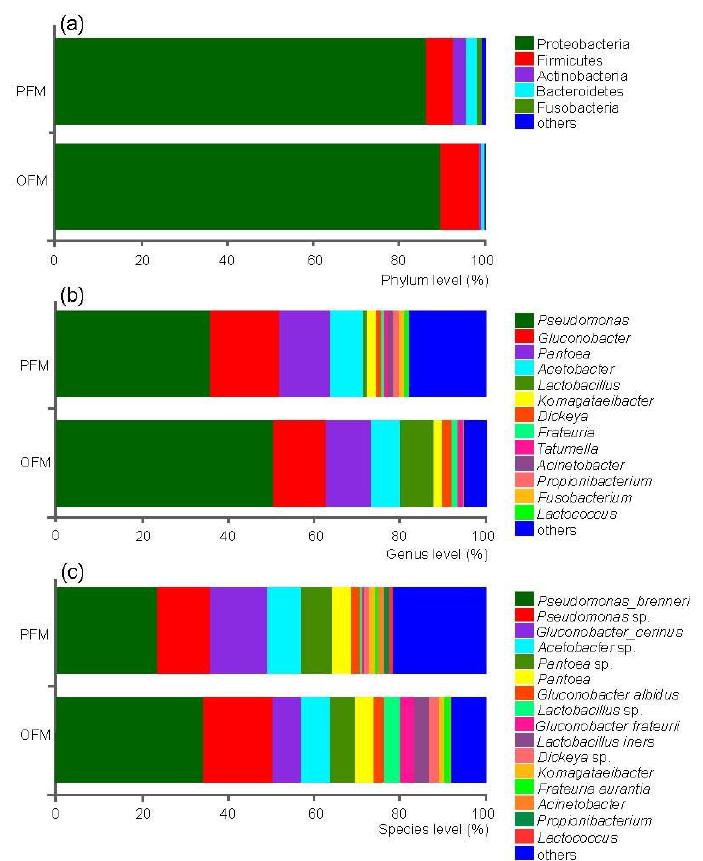
Figure 1. Microbial composition identified in the peach fruit moth (PFM) Carposina sasakii and the oriental fruit moth (OFM) Grapholita molesta . Community composition of the microbiome on phylum ( a ), genus ( b ), and species ( c ) levels for the PFM and OFM were illustrated. The width of the bar represents the relative abundance of each taxa. Insects 2020 , 11 , 0